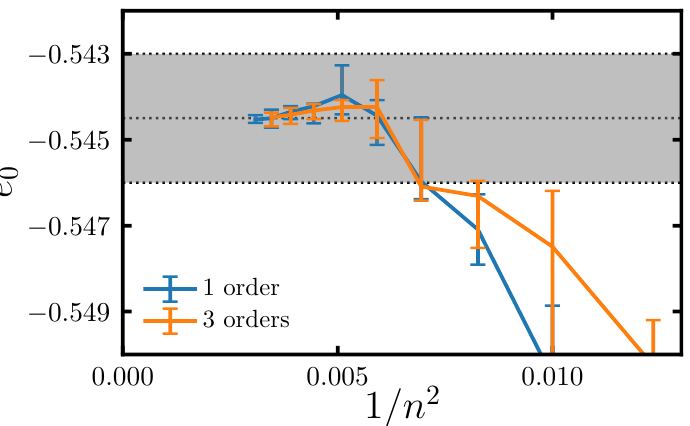
Figure 3: For the TLHAF: Best values of the ground-state energy per site e corresponding uncertainties) for several orders n (blue) and groups of 3 orders [ n − 1, n + 1 ] (orange), as a function of 1 / n 2 . The grey area denotes the value from exact diagonalization (with uncertainties) [ 8 ]